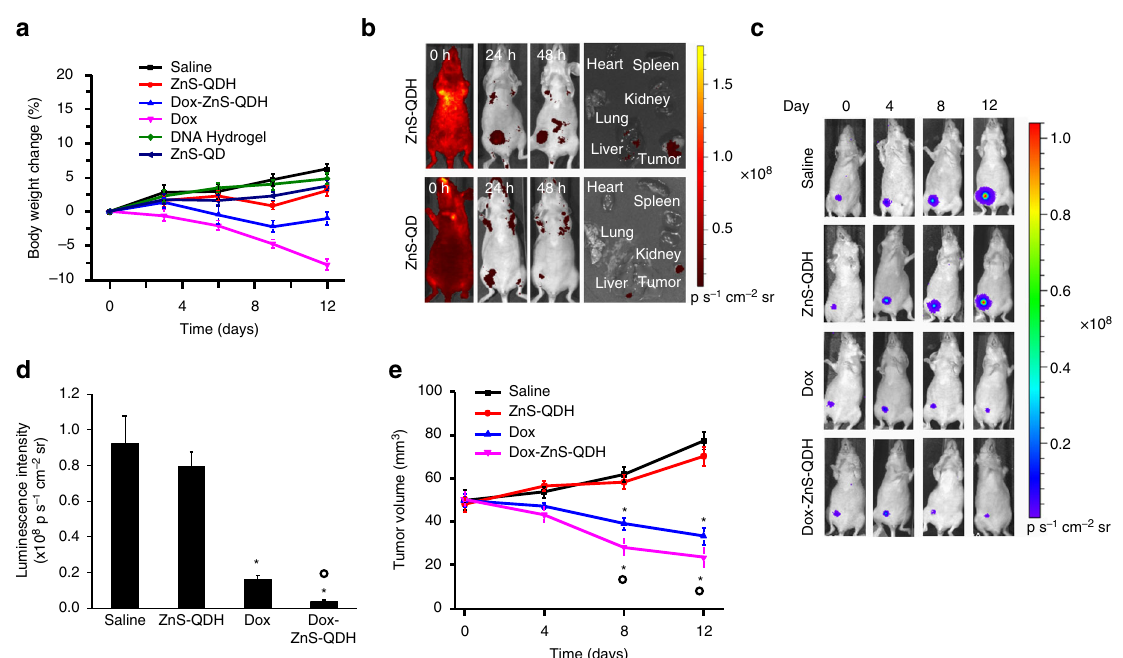
Fig. 6 Analysis of bioavailability and in vivo ef fi cacy. a Maximum tolerable dose of saline, ZnS-QDH, Dox, Dox-ZnS-QDH, DNA hydrogel, and ZnS-QD treated healthy mice measured by percentage of body weight change from day 0 to 12 ( n = 5 per group). b Biodistribution of ZnS-QD and ZnS-QDH after 48 h treatment. c Bioluminescence images of tumors of treated mice from day 0 to 12. d Quanti fi cation of bioluminescence on day 12 of treatment regimen. e Analysis of tumor volume of treated MDA-MB-231 breast cancer xenograft mice ( n = 5 per group). All error bars represent s.e.m. ( n = 5). ANOVA one-way analysis of treated vs. saline control * P < 0.05, vs. Dox ° P <